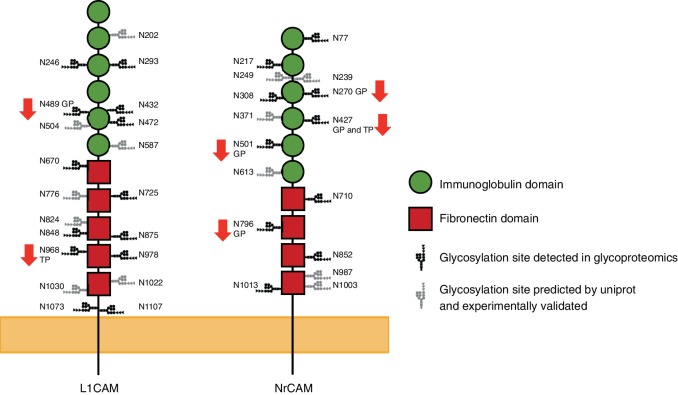
Schematic representation of the mouse L1CAM and NrCAM with their hypoglycosylated sites.The changes in the glycosylation status are based on glycoproteomic (GP) or total proteomic (TP) results. N-glycosylation sites experimentally validated elsewhere (Zielinska et al., 2010) are also represented.